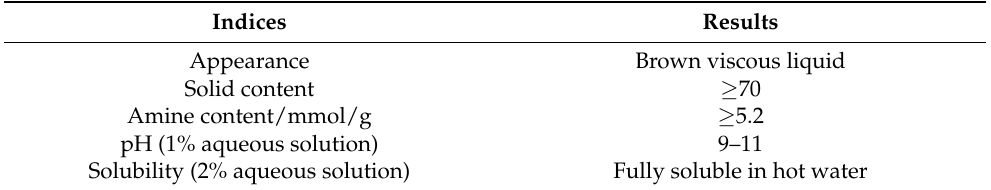
Table 2. Technical indices of kzw-803l